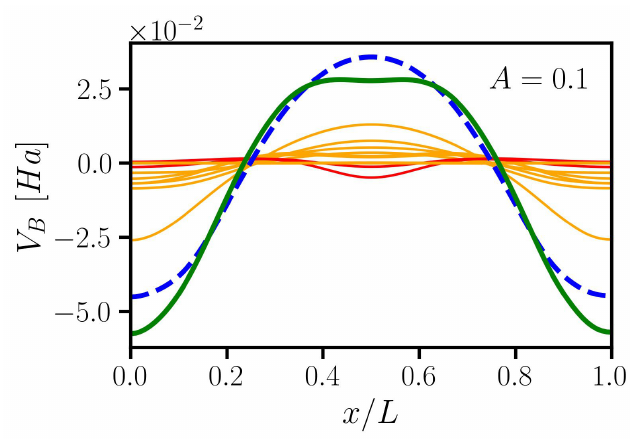
Figure 5: Comparison of the quantum Bohm potentials in the zero-temperature limit = 2 and θ = 0.01. The deviations of the standard Bohm potential (dashed at r s blue) from the exact many-fermion quantum Bohm potential (green) are not just due to thermal excitations. The individual contribution of orbitals with one maximum in the center (orange) and with more that one maximum (red) are also illustrated.